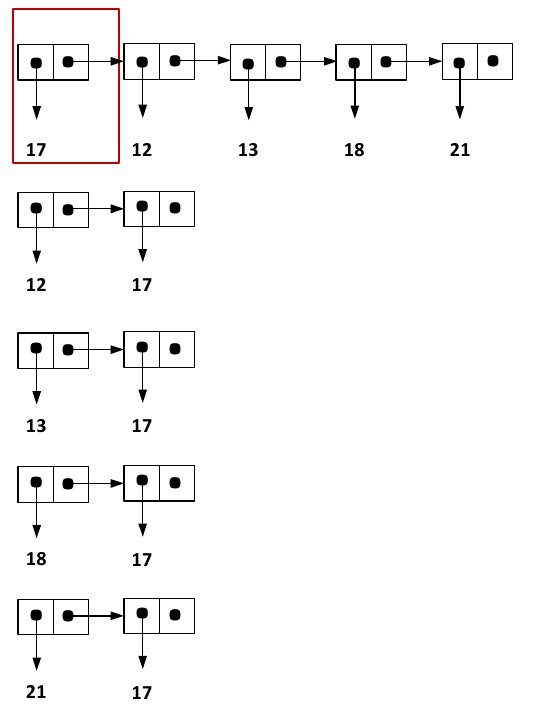
Figure 3. Adjacency list